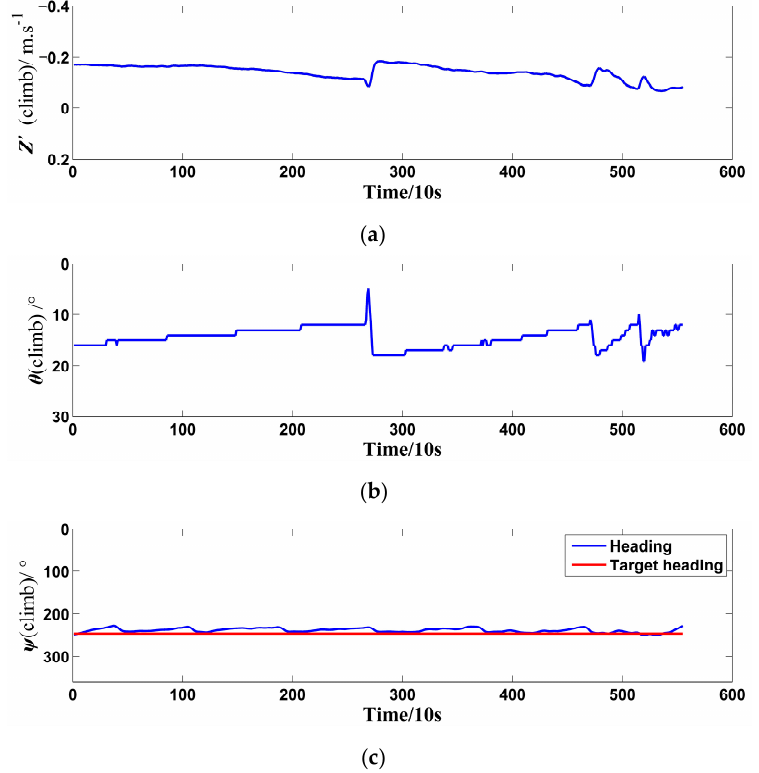
Figure 15. Datasets of Petrel-L in climb motion: ( a ) vertical velocity, ( b ) pitch angle, ( c ) heading.